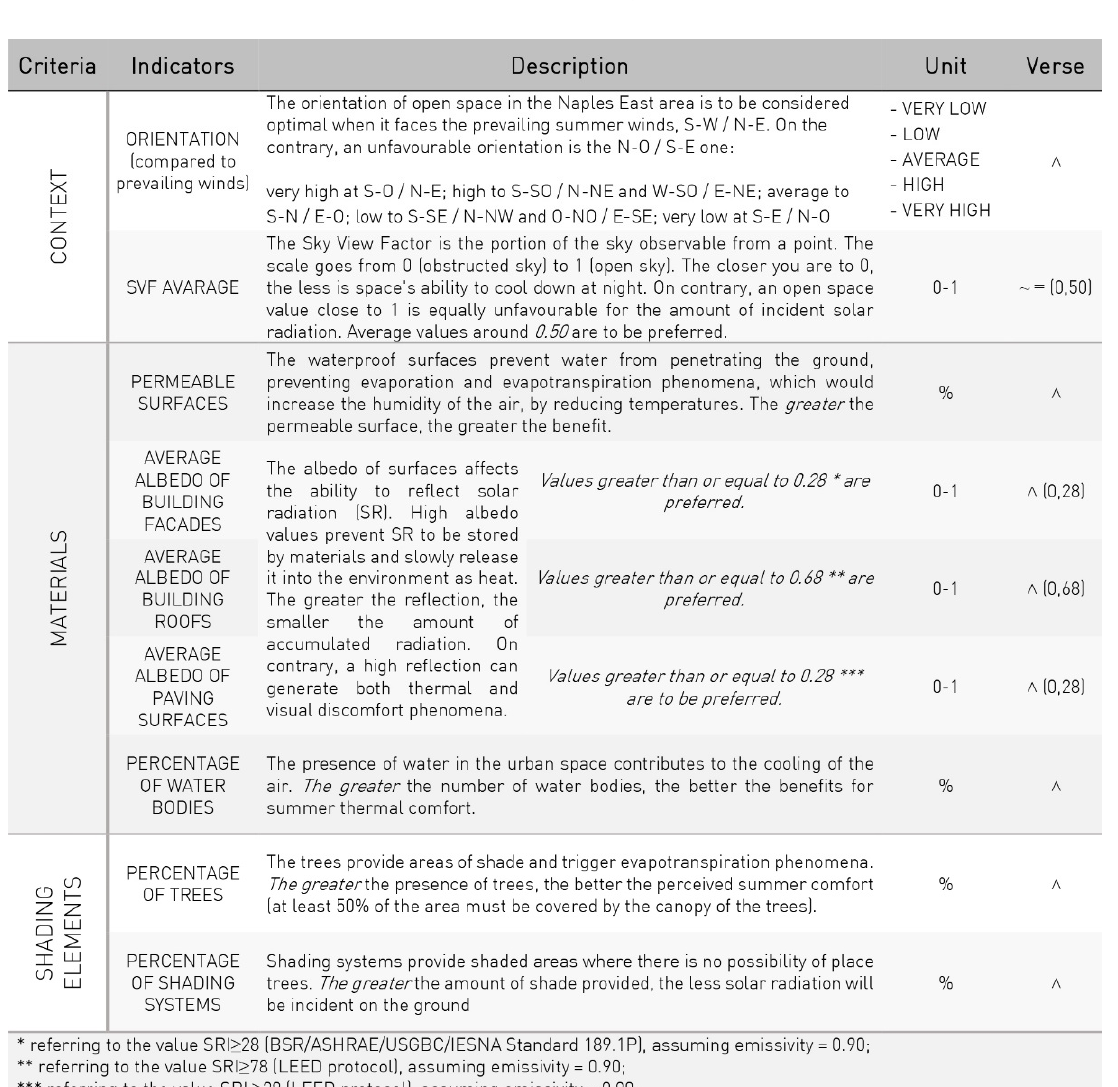
Figure 6. Definition of the indicators system.